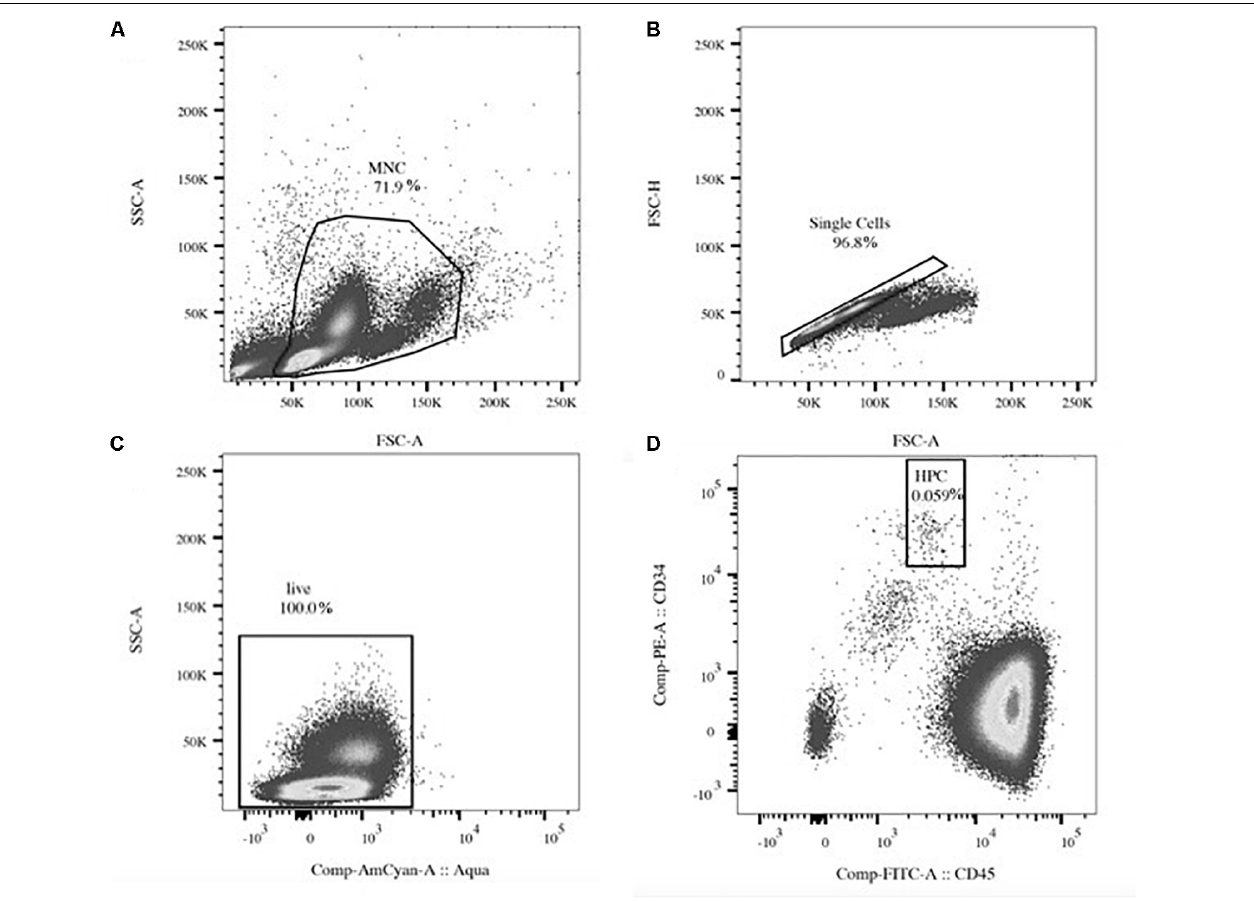
FIGURE 1 | Exemplary flow cytometry gating. Light scatter gating of the mononuclear cell (MNC, A ) population and doublet exclusion (single cells, B ). Fluorescent gating of live cells (C) and the hematopoietic stem and progenitor cell (HPC) population identified as CD34+/CD45dim within the MNC gate (D) . Percent numbers indicate cell amount relative to the parent